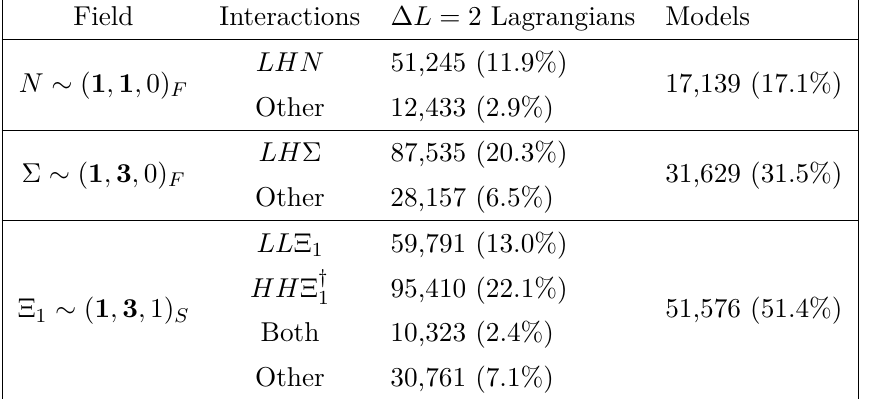
Table 5. The table shows the number of unfiltered models in which the seesaw fields appear. The category ‘other’ includes interactions such as LϕN , where one of the SM fields in the interaction has been replaced with an exotic copy, as well as couplings involving other exotic fields whose quantum numbers are unrelated to those of SM